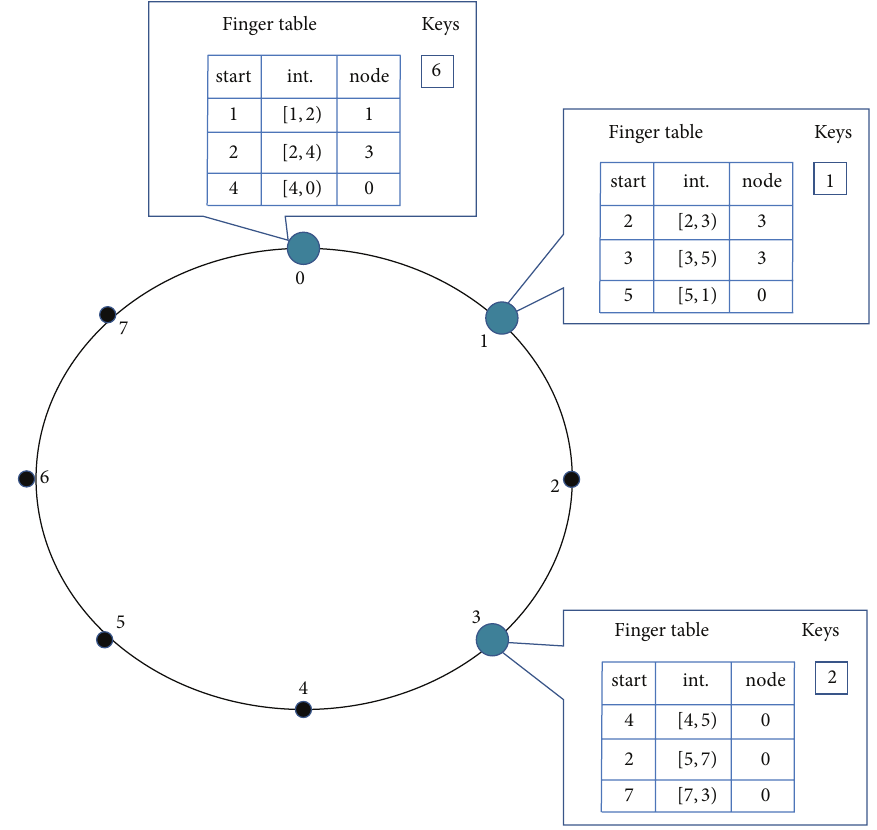
Figure 1: Example of Chord ring with finger